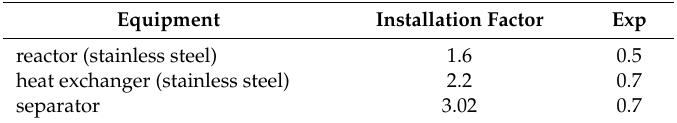
Table 3. Installation factor and exponential factor.